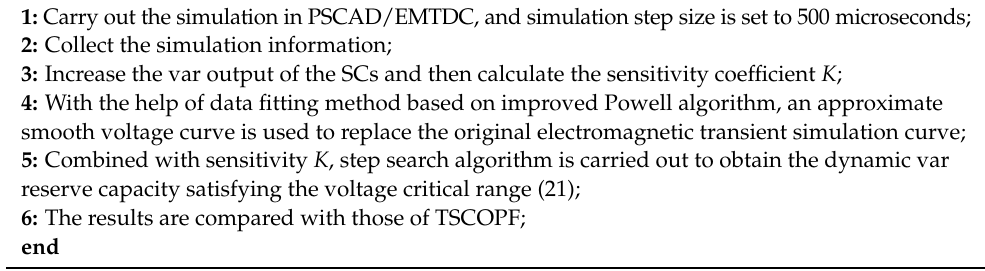
Algorithm 2: The whole calculation process of dynamic var reserve capacity.